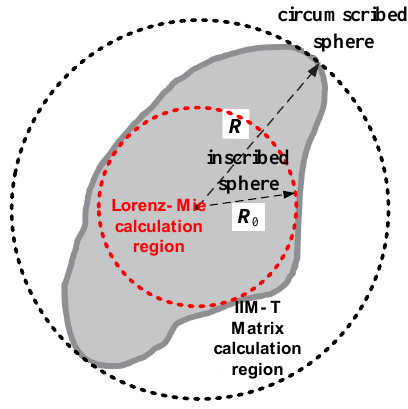
Figure 2. A schematic diagram of the division of the calculation region of the non-spherical scatterer. In this figure, R 0 is the radius of the inscribed sphere, while R is the radius of the circumscribed sphere.